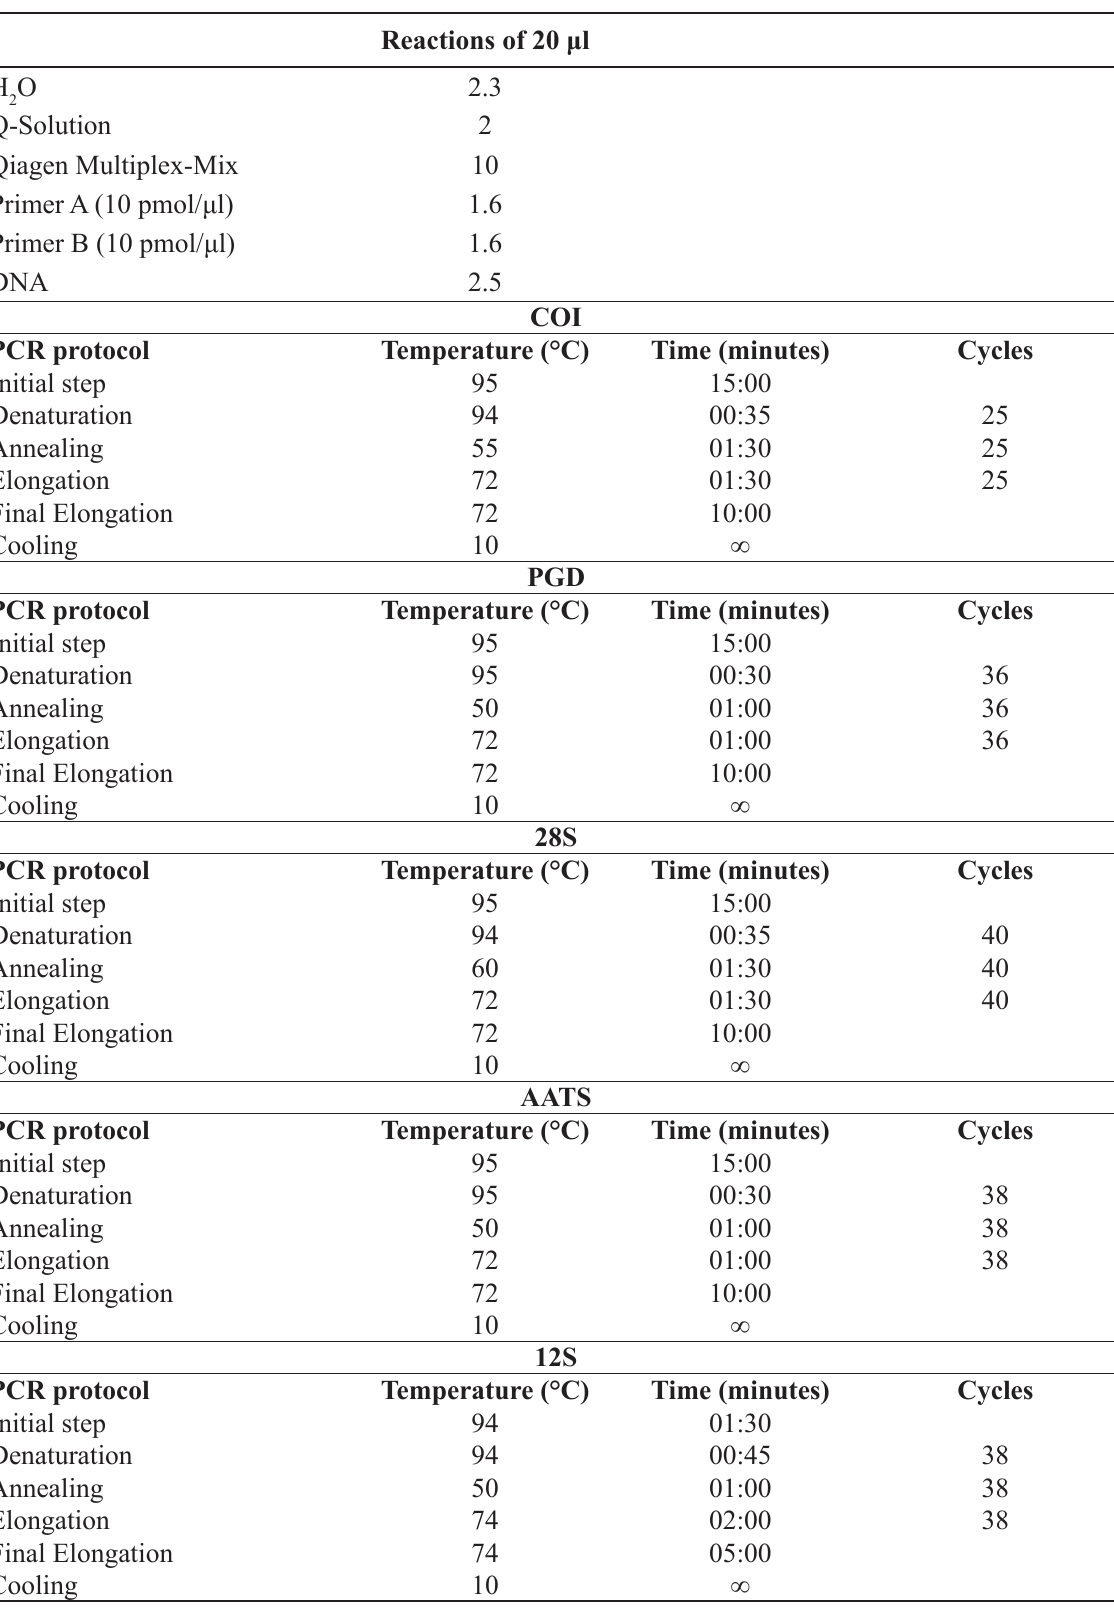
Table 3. Detailed PCR protocols for each